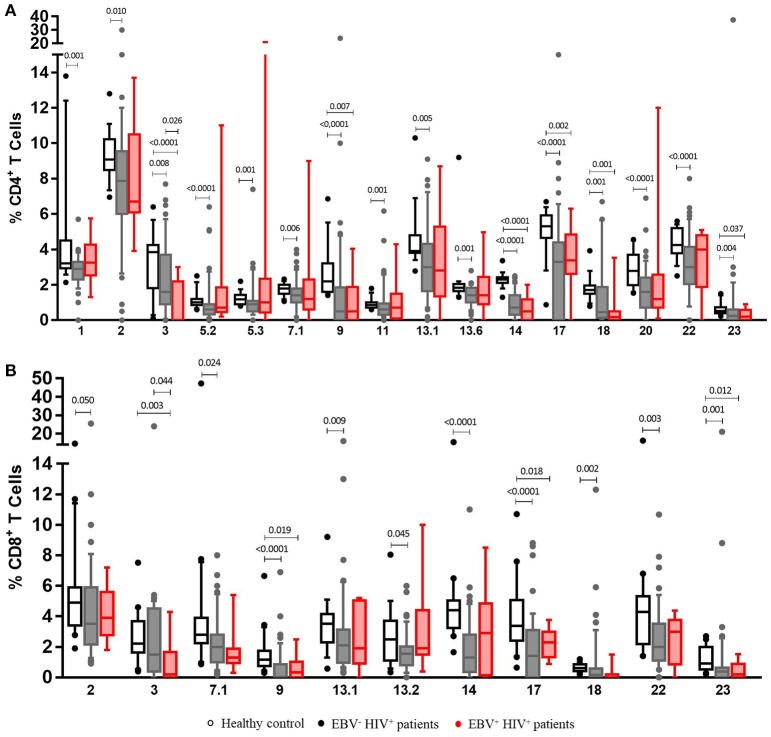
Clonotypic distribution of T cells comparing EBV−HIV+ versus EBV+HIV+ patients under EBV-stimulated conditions. Peripheral blood samples of HIV+ patients and healthy controls were cultured in vitro with EBV lysate. The distribution of CD4+ (A) and CD8+ (B) T cells positive for TCR-Vβ families was analyzed with specific mAbs and flow cytometry. Box and whisker plots show range, median, and interquartile range of percentage of T cells positive for individual Vβ families. Mann-Whitney U-test was used for comparisons between groups.